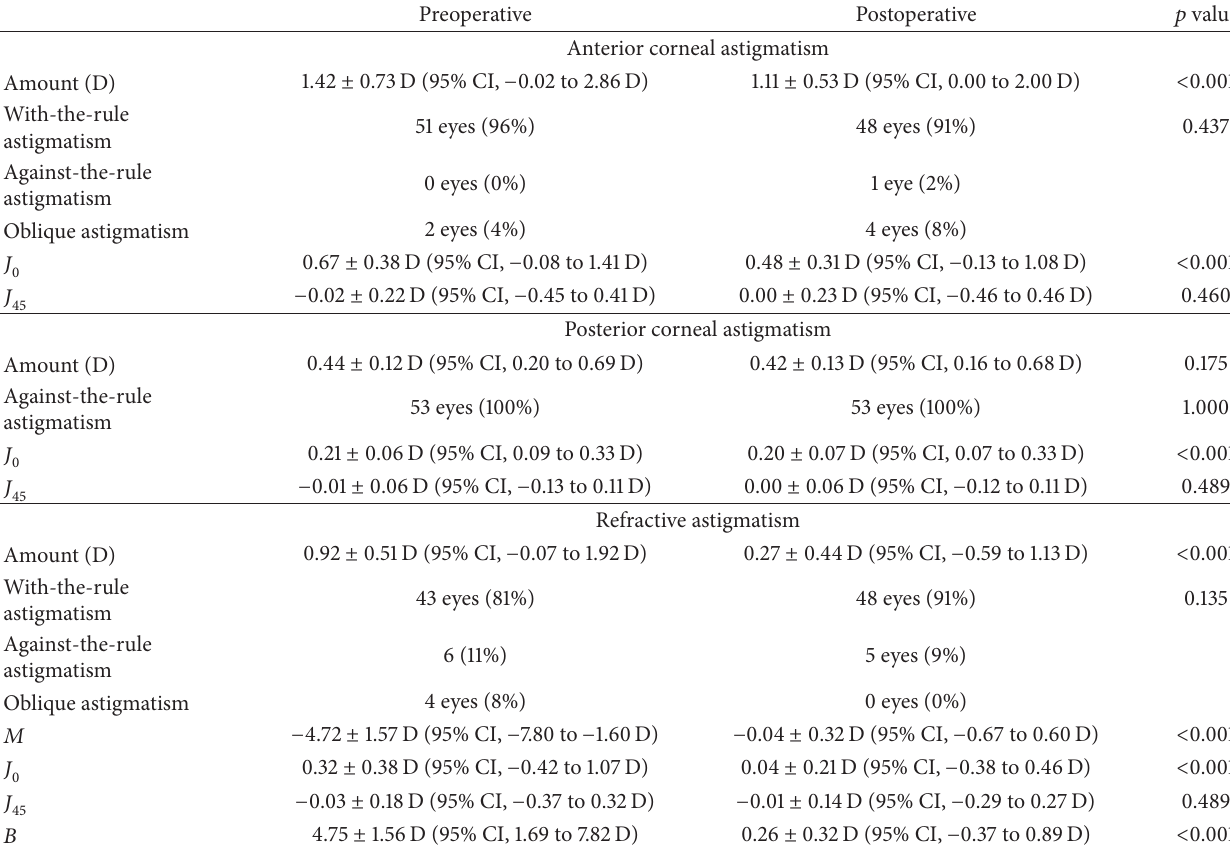
Table 2: Preoperative and postoperative anterior and posterior corneal astigmatism, refractive astigmatism, and refraction after vectorial conversion in eyes undergoing refractive lenticule extraction.